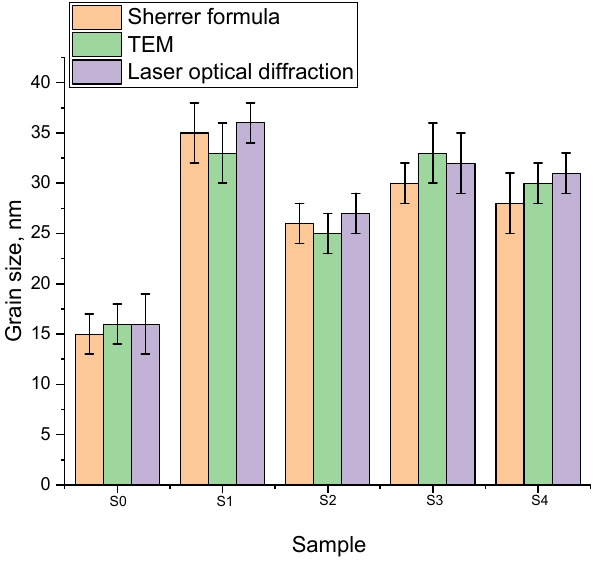
Figure 5. Results of comparative analysis of nanoparticle size measurements.